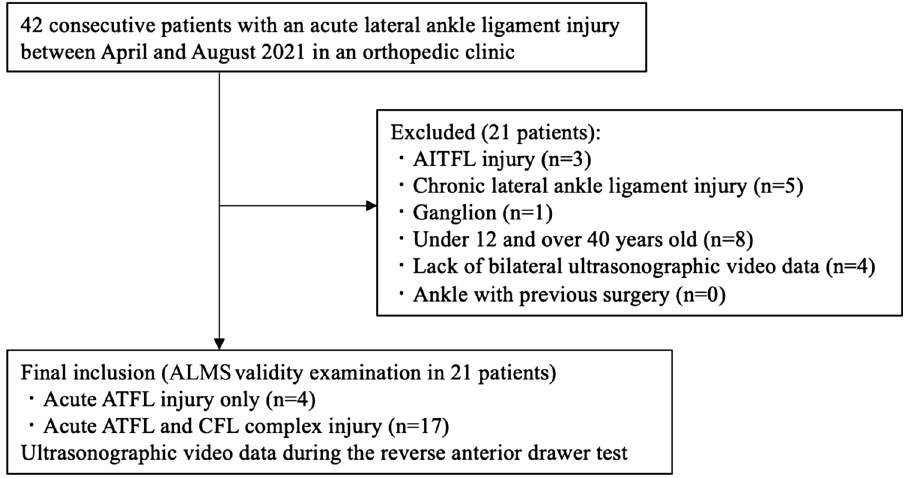
Figure 2. Flowchart of the patient selection process. AITFL anterior inferior tibiofibular ligament, ALMS Automated Length Measurement System, ATFL anterior talofibular ligament, CFL calcaneofibular ligament.